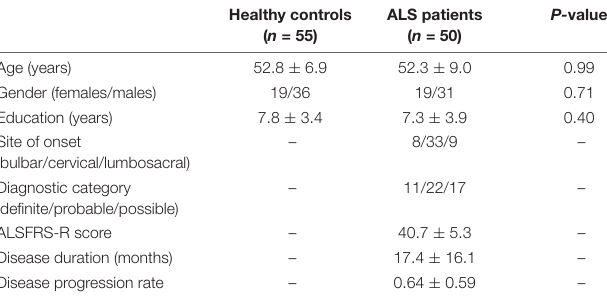
TABLE 1 | Subjects’ demographic and clinical